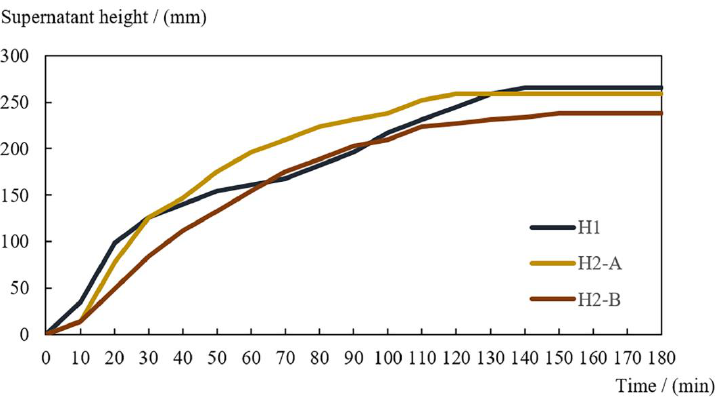
Figure 5. Folding line graph of the supernatant height of alkaline copper carbonate suspensions with the time required for different preparation methods.